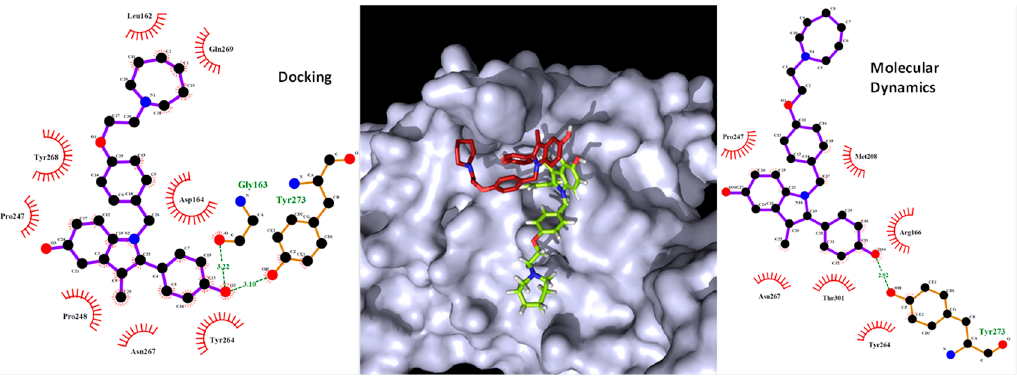
Figure 9. Docking (red) and MD (green) result from the interaction of bazedoxifene with PLpro. For the MD simulation against RdRp, again digoxin, chloroquine, dronedarone, and remedesivir were studied. Special attention is put on remdesivir as it is a known ligand for this polymerase. The results for the interaction of the three drugs with RdRp showed that all of them stayed in the active site. Analyzing remdesivir in detail, the RMSD plot shows an average value of 0.5 nm, rising from 0.2 to 0.7 nm in the first 10 ns and stabi- lizing at around 0.3 nm after that. This result was compared with digoxin and dronedarone, whose RMSD values are constant throughout the simulation with a RMSD around 0.5 nm (Figure 10). This agrees with the HBs (between three and four) formed in almost the whole